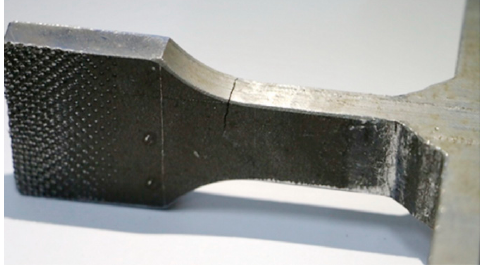
Figure 9. Fracture position of a welded joint of a sample that received UPT reapplications (Number of cycles: 1,104,878 cycles, delta sigma: 255 MPa).